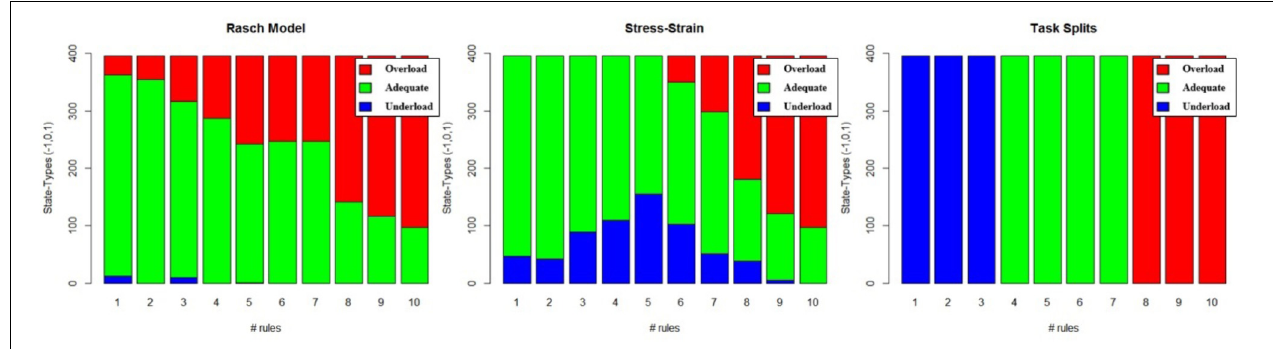
FIGURE 2 | Example breakdown of classification under each of the three labeling methods. (Left) Rasch model, (Middle) Stress–strain, and (Right) Difficulty Split.